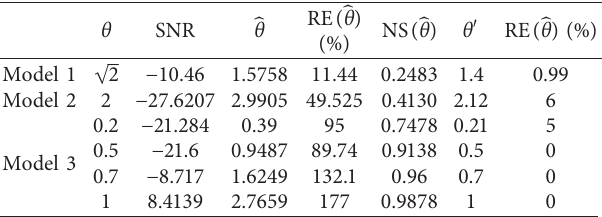
All the results are obtained via the average of 200 generated